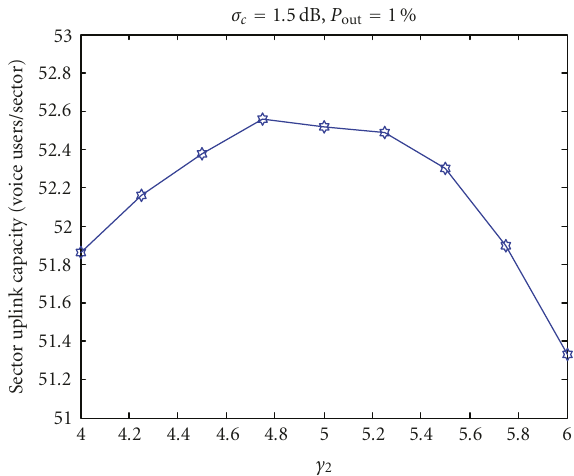
Figure 13: E ff ect of the propagation exponent γ 2 on the sector up- link